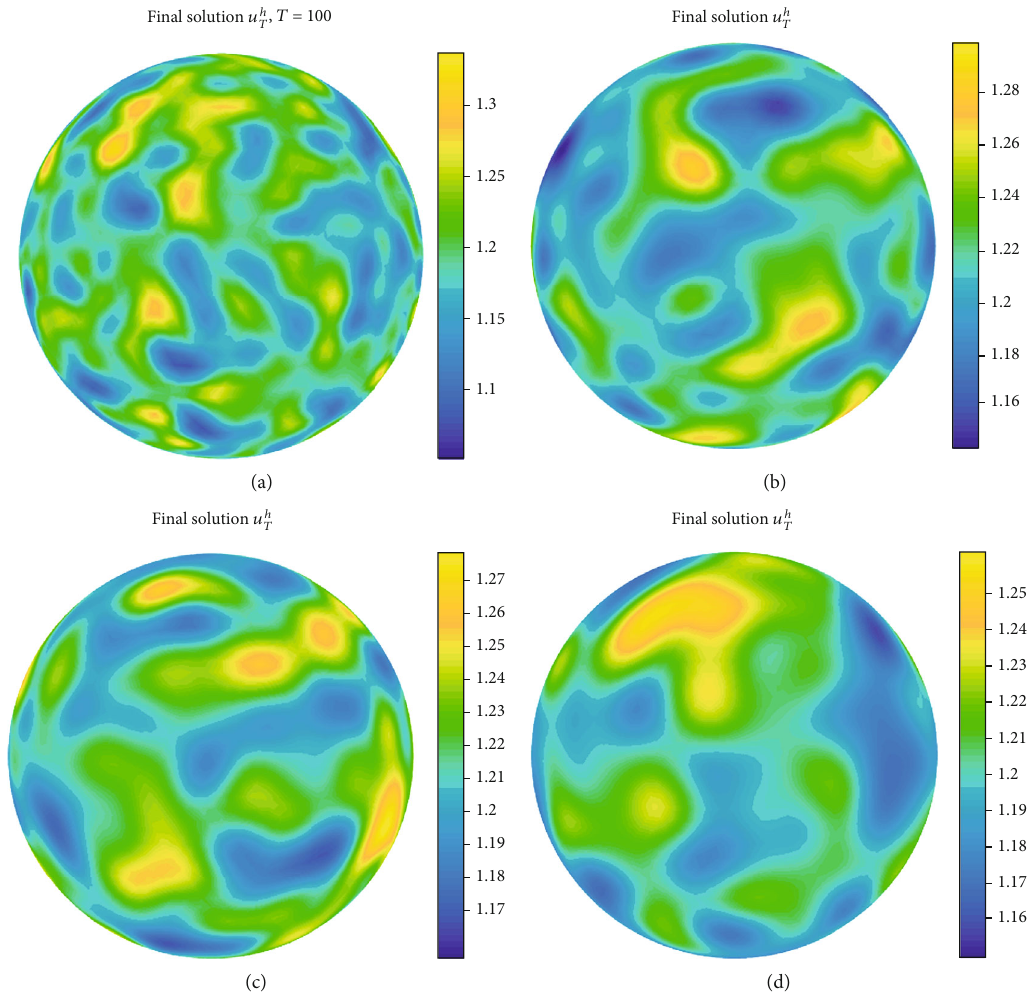
= 1/40 , D = 1/4 , a = 0 : 01 , u v